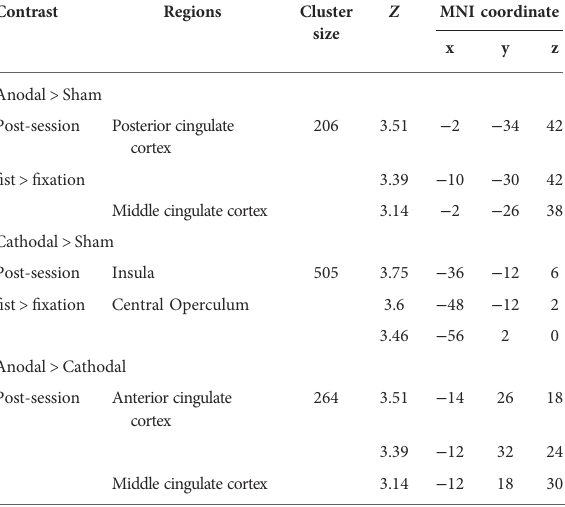
TABLE 2 The results of whole brain analysis of